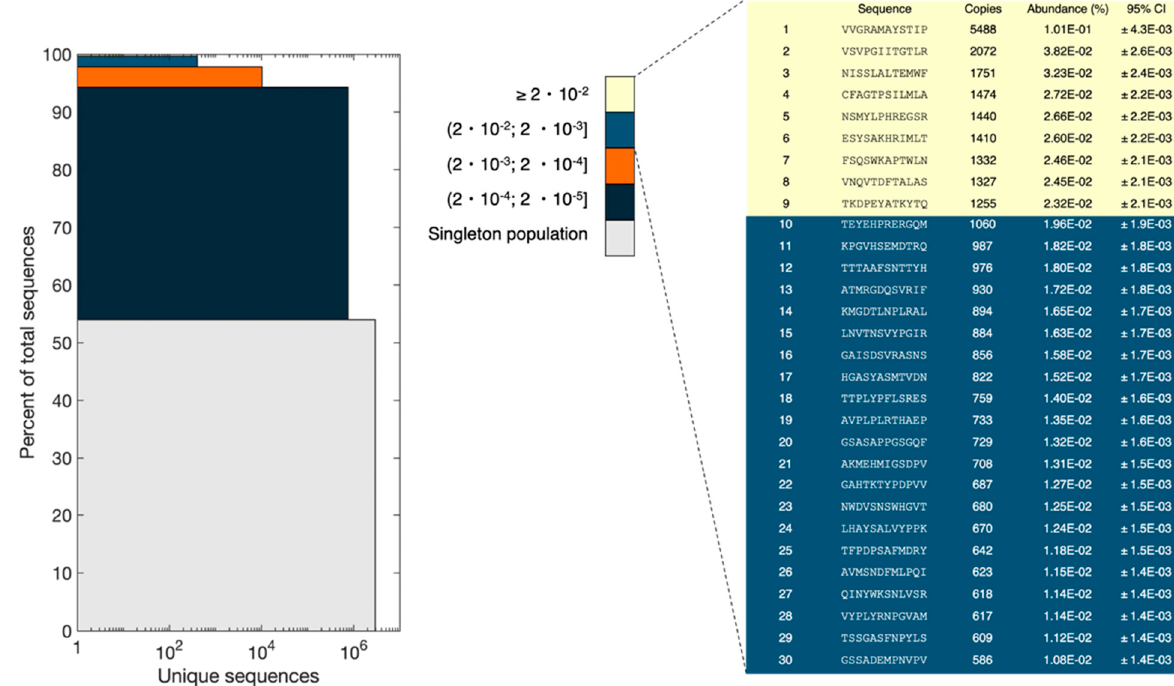
Figure 6. Stacked bar plot with color-coded segments grouping sequences according to their abun- dance (see color key). The height of each segment illustrates the sum of abundance for each segment and the width corresponds to the number of unique sequences in each segment. Grey: 2,927,839 reads, 54%; dark blue: 752,541 reads, 40.3%; orange: 10,258 reads, 3.5%; light blue: 406 reads, 1.9%; yellow: 9 reads, 0.3%. The top 30 peptides are shown on the right and colored according to the bin they are included in. The 95% confidence intervals with Bonferroni correction are shown to evaluate the validity of the ranking.